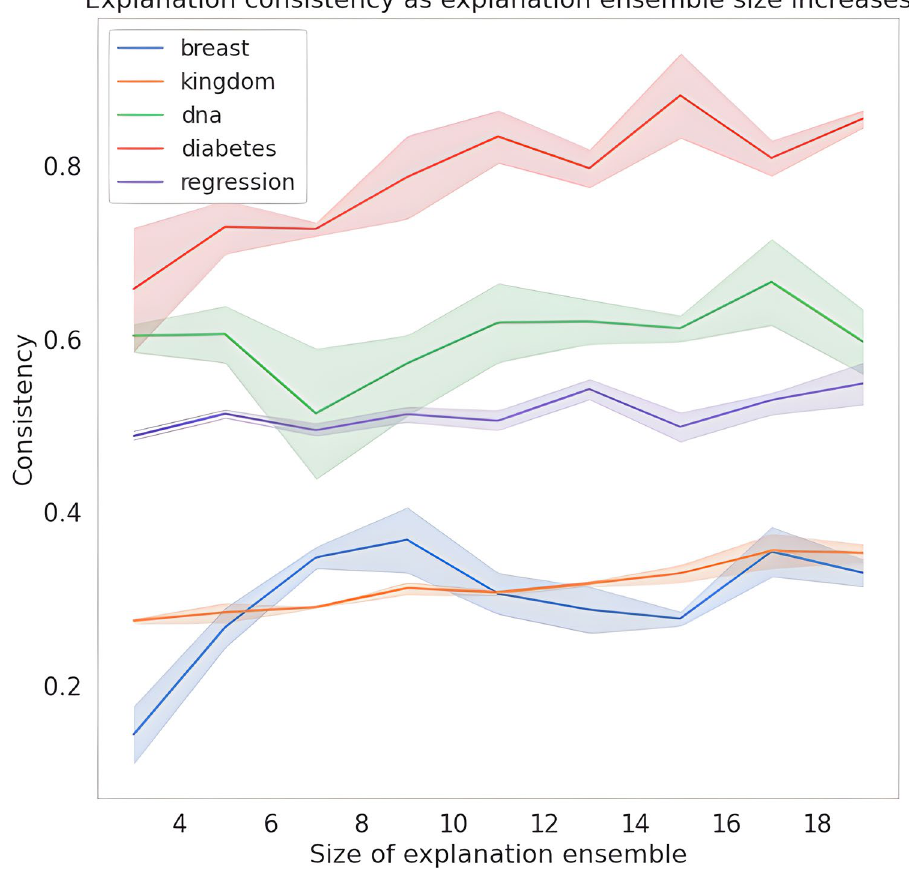
Figure 4. Explanation consistency (± standard error) of explanation ensembles as the number of sub-models within an ensemble increases across all datasets.